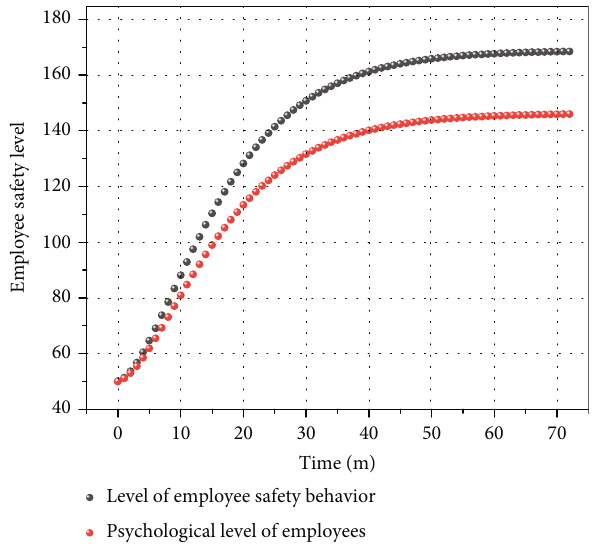
Figure 7: Population status is